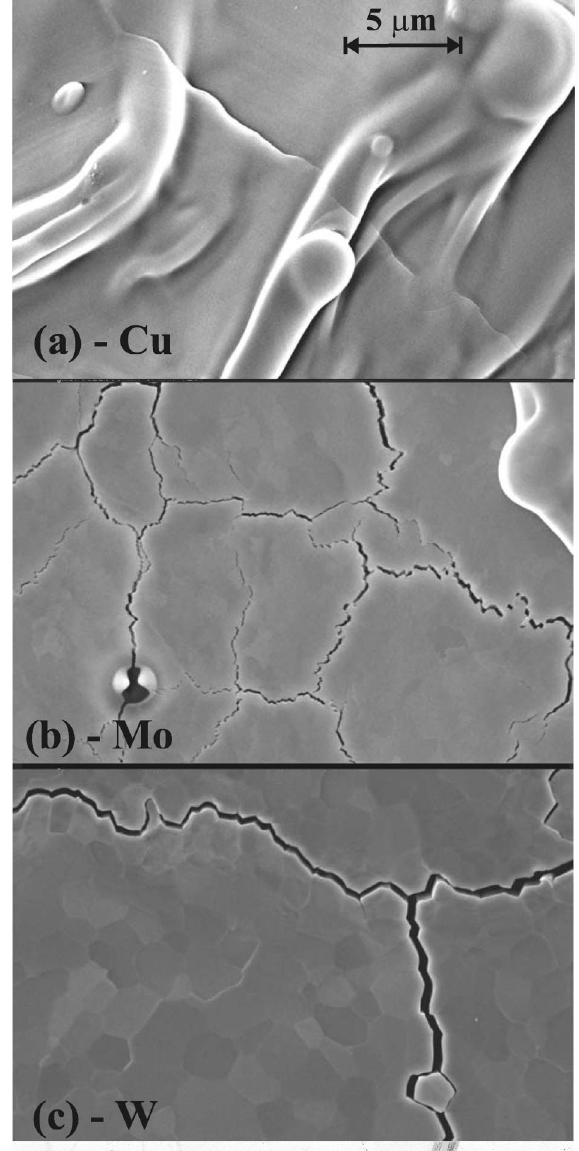
FIG. 9. SEM images, magnified view of the regions in Fig. 7 (magnification 5000). The arrow indicates 5 (cid:14) m